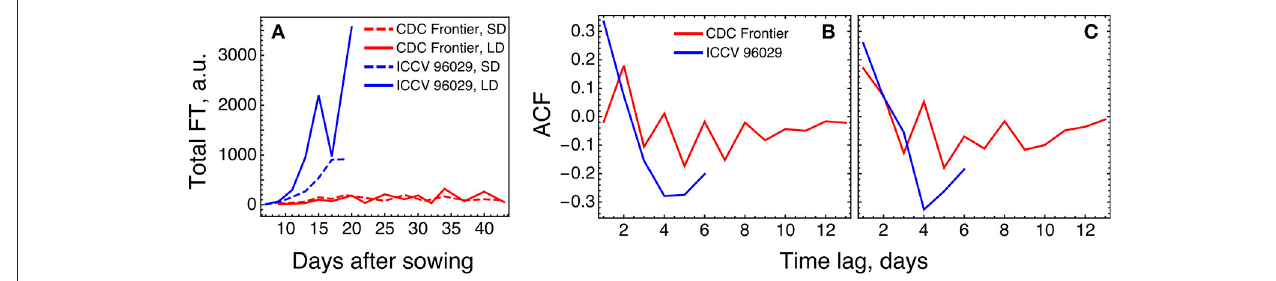
FIGURE 7 | Difference in FT behavior between ICCV 96029 and CDC Frontier, based on the expression data from (Ridge et al., 2017). (A) The dynamics of the sum of concentrations of all five FT transcripts, for the two cultivars and two growth conditions. Developing floral buds were first detected at 15 days (under SD) and 13 days (LD) in ICCV 96029 and at 31 days (SD) and 32 days (LD) in CDC Frontier (Ridge et al., 2017). (B) Autocorrelation function (ACF) for the expression data time series of the FT genes. ACF estimates similarity (correlation) between data points as a function of the time lag between them. For each time lag value, an ACF value was calculated for the expression time series for each FT gene and growth condition (SD and LD), and then an average ACF was calculated over the FT genes and conditions. (C) The same as in (B) but for the expression dynamics of the genes TFL1a , TFL1b , FD , LFY , and AP1 .